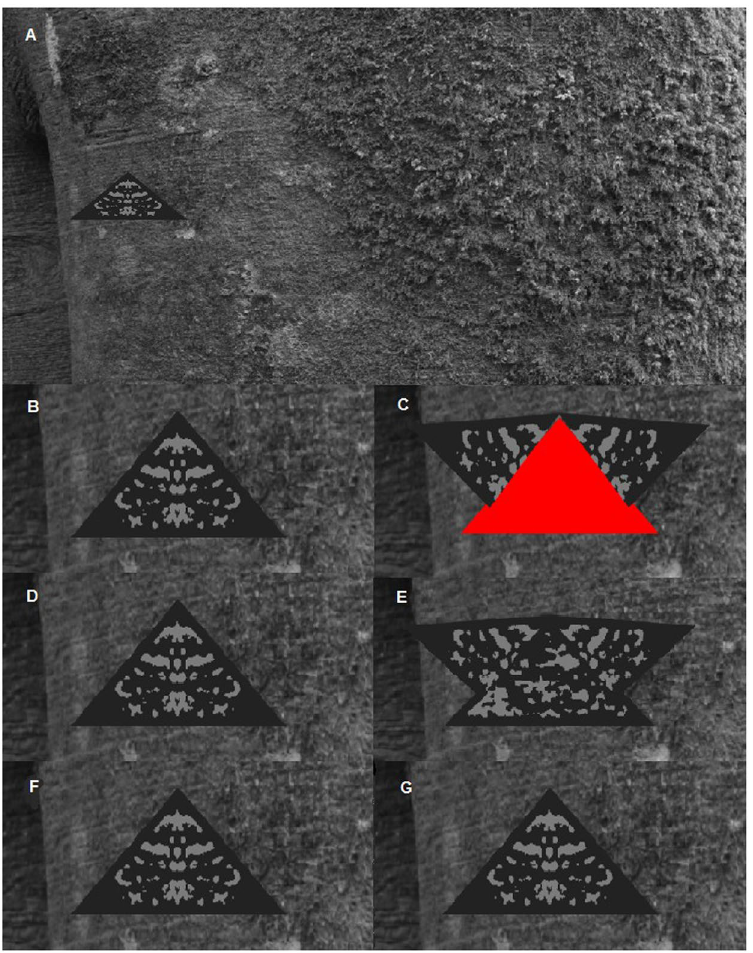
Figure 3. ( A ) Example of an artificial prey item on the natural bark background image. Conspicuous deimatic prey with the forewings closed ( B ) and open ( C ), revealing bright red underwing colouration. Background matching prey with the forewings closed ( D ) and open ( E ), revealing background matching underwing colouration. Control prey ( F ) with the forewings always closed ( G